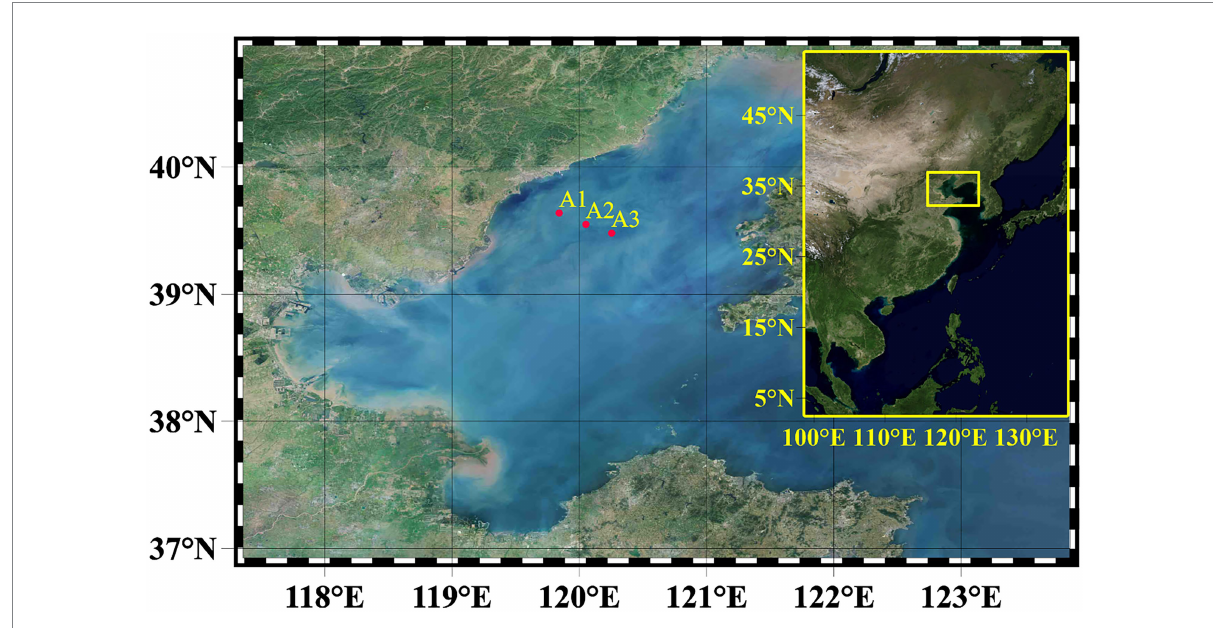
FIGURE 1 The map showing the sampling stations in the Bohai Sea (BHS). In summary, samples from 3 sites (A1–A3) were used for molecular